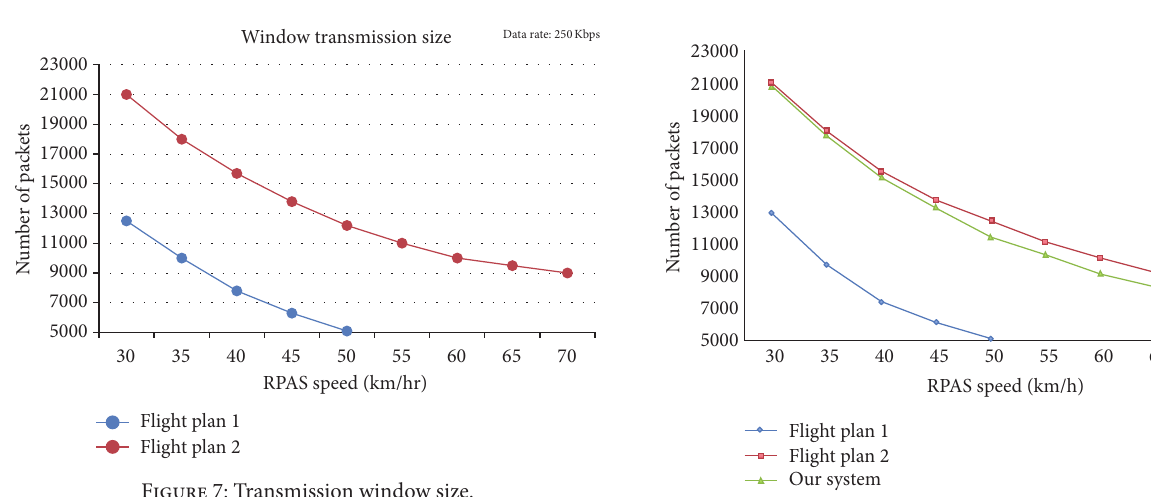
Figure 8: Sensor network interface.